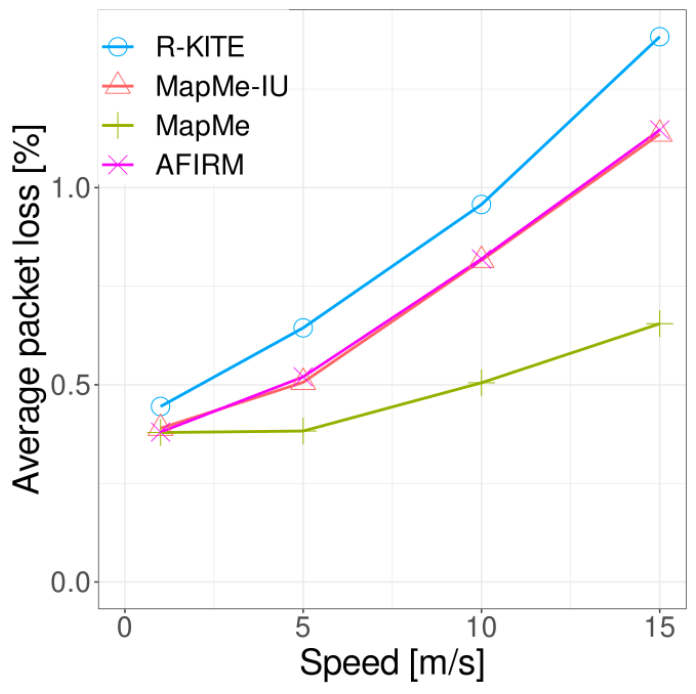
Figure 9. Data loss